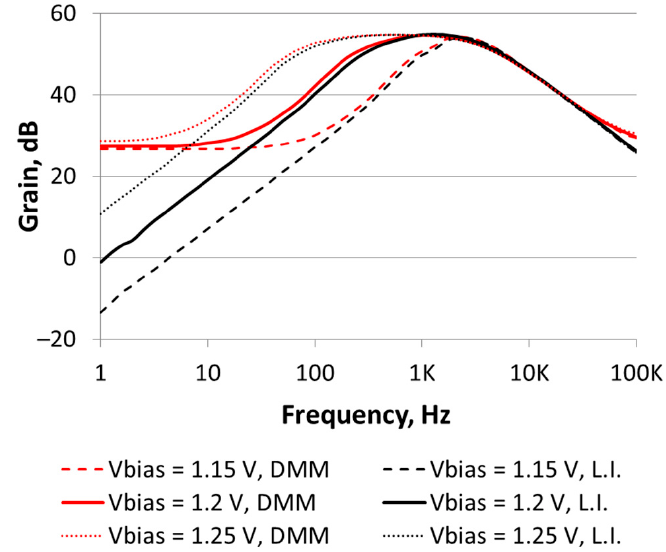
Figure 6. Frequency response of the amplifier BPF’s voltage gain, plot for three different V BIAS values: 1.15, 1.2 and 1.25 V. For each V BIAS , measurements are taken either with a digital multimeter (DMM) or with a lock-in amplifier (LIA). Table 3. Active BPF measured